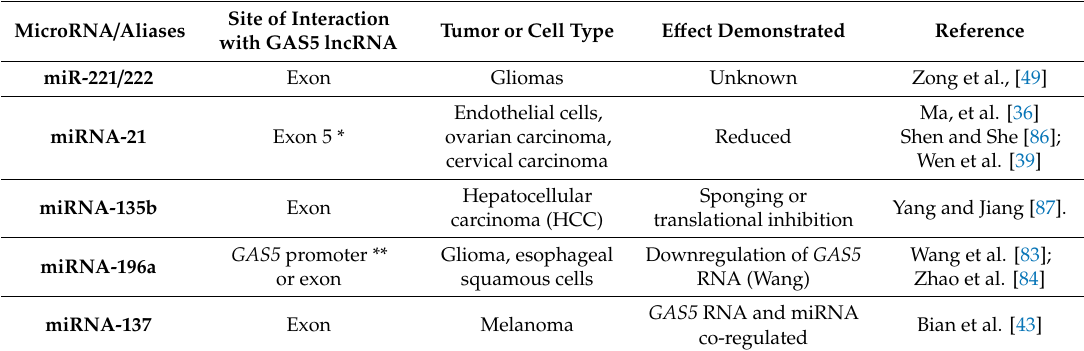
Table 2. MicroRNA sequences shown to interact with GAS5